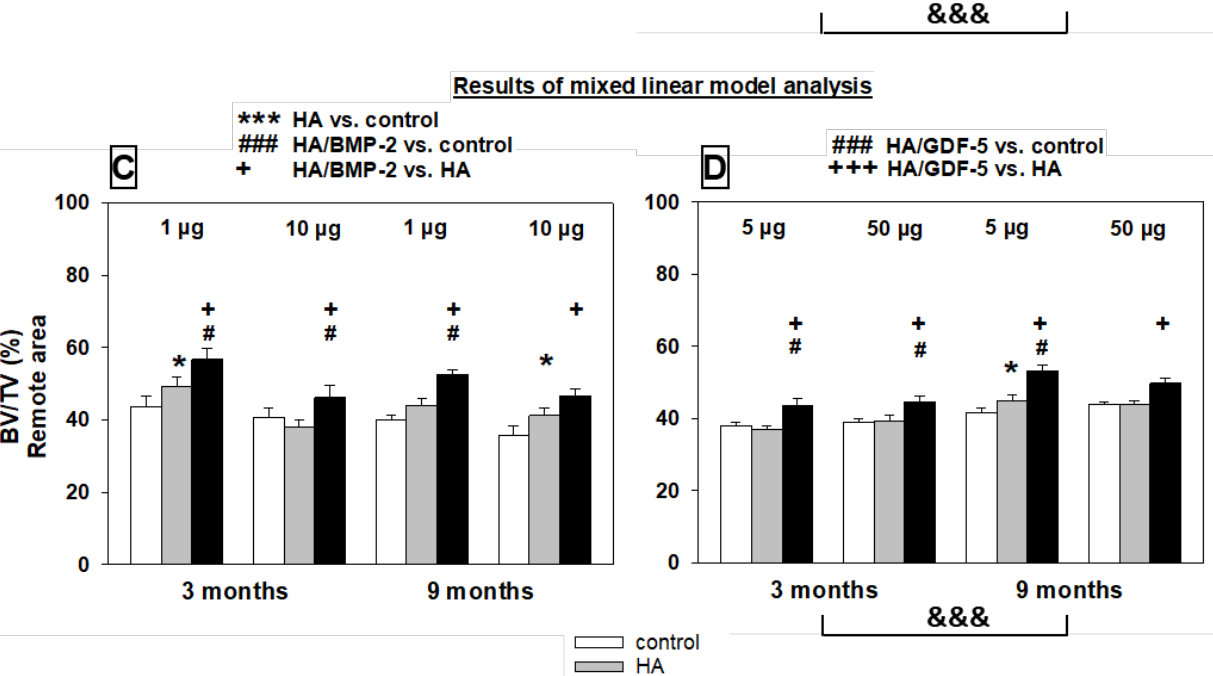
Figure 6. Increase of bone volume (%) in paraffin sections of lumbar vertebral bodies (L3 = control; L4 = HA/BMP; L5 = HA) of all investigated groups in the vicinity of the injection channel ( A , B ) and in the remote area ( C , D ). Results of the mixed linear model analysis (compare with Tables 2 and S2); *** p < 0.001, * p ≤ 0.05 for HA compared to non-injected control; ### p < 0.001, # p ≤ 0.05 for HA/BMP compared to non-injected control; and +++ p < 0.001, + p ≤ 0.05 for HA/BMP compared to HA; &&& p < 0.001 for 9 months compared to 3 months. Please note: The linear mixed effects model was used to analyze global effects and overall interactions of the main effects treatment (group), time point (time), BMP dose (dose), and distance from the injection channel (area); subsequently, the non-par- ametric multigroup Kruskal – Wallis and two-sided Wilcoxon tests were applied for the comparison of paired samples within one group, and the multigroup Friedman and two-sided Mann – Whitney U-tests for statistical evaluation of differences between groups with the above-mentioned signifi- cance levels.